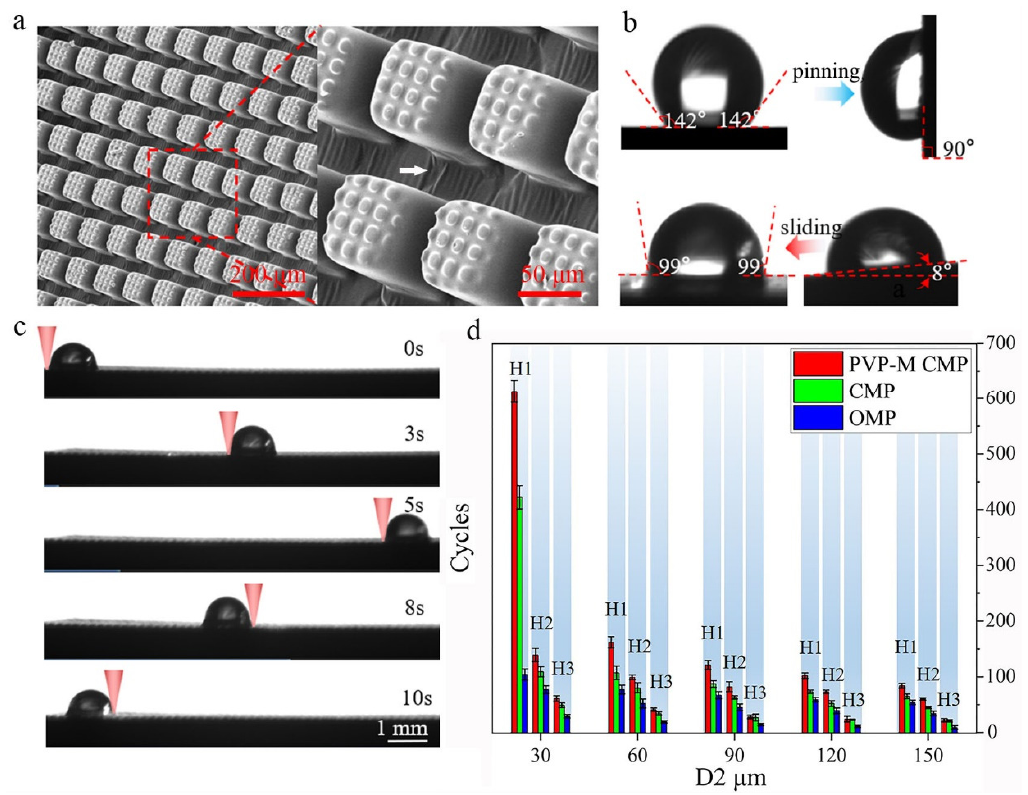
Figure 2. Fabrication results and performance of HD-PTSS. ( a ) Morphology of HD-PTSS. ( b ) Variation of contact and sliding angle of the functional slippery surface. ( c ) Reciprocating transportation of droplet driven by NIR light. ( d ) Droplet manipulating repetitions of HD-PTSS with different morphologic parameters.